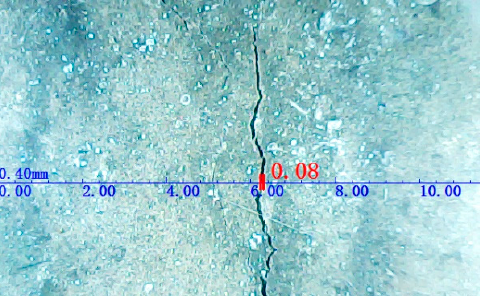
Figure 7. Method of measuring crack dimensions.